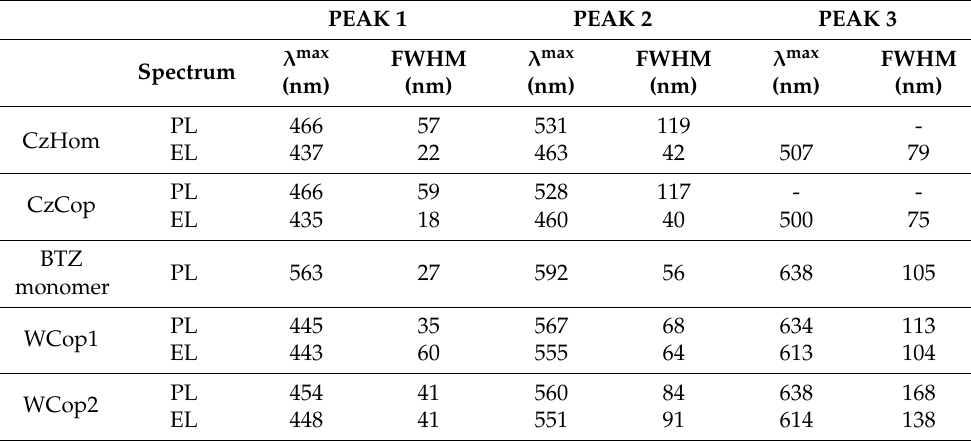
Table 4. Results of the deconvolution analysis of the PL and EL